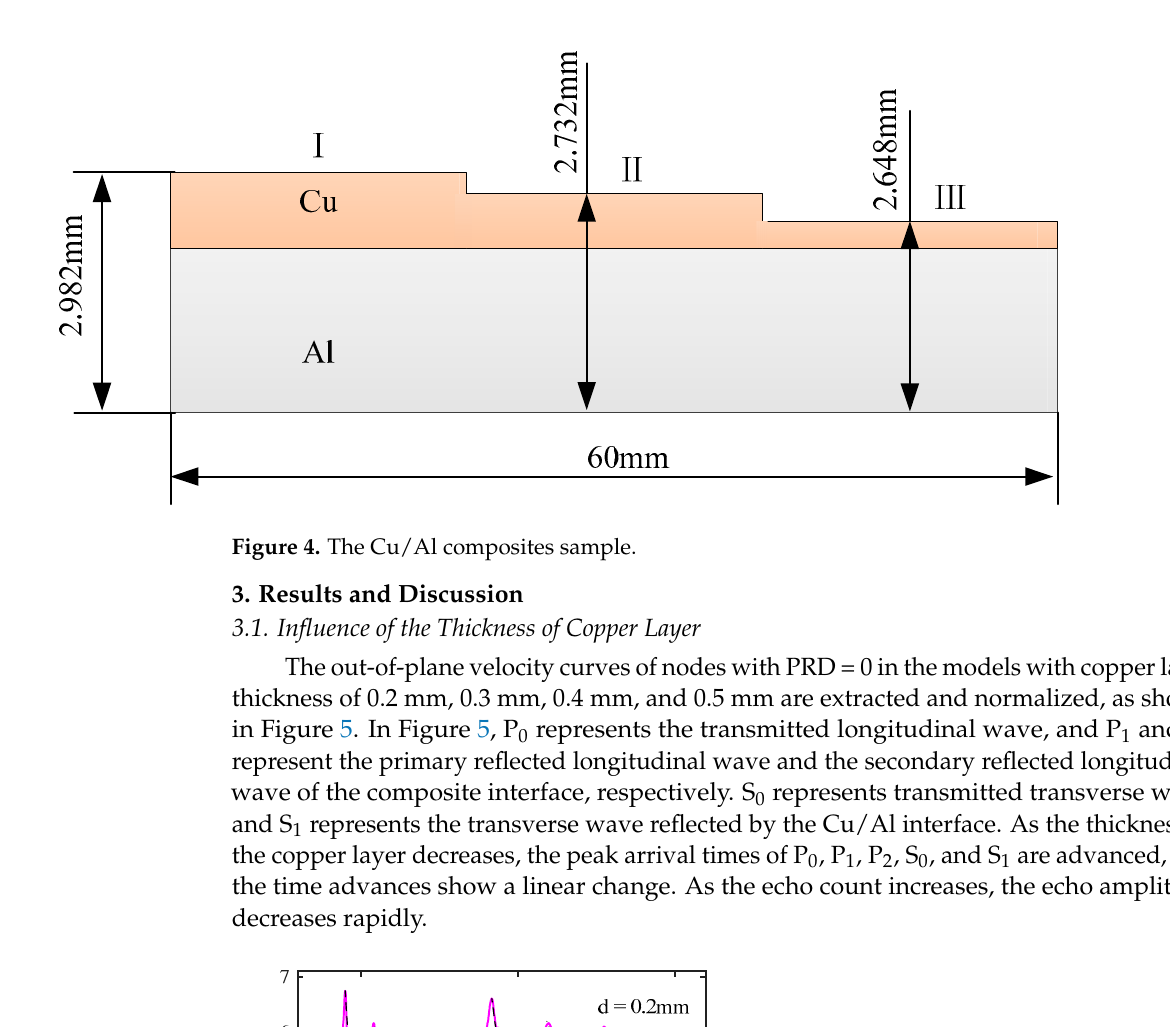
(12) The peak arrival times of P 0 and P 1 of nodes with PRD values of 0 mm, 0.25 mm, 0.5 mm, 0.75 mm, 1 mm, 1.25 mm, and 1.5 mm are extracted and then substituted into Equa- tions (10) and (12) to calculate the thickness of the Cu layer and the Al layer. The relation- ship between the calculated results of the thickness of each layer and PRD is shown in Figure 6. With the increase of PRD, the calculated results of d show a decreasing trend, while the calculated results of L show an increasing trend. When the PRD is constant, the error between the calculated and actual values of the thickness of Cu and Al layers de- crease with the increase of the pulsed laser radius. According to the above analysis, when using laser ultrasound to measure the thickness of Cu/Al laminates by transmission method, the spot radius of the pulsed laser should be set to a larger value to reduce the impact of PRD on the measurement results.